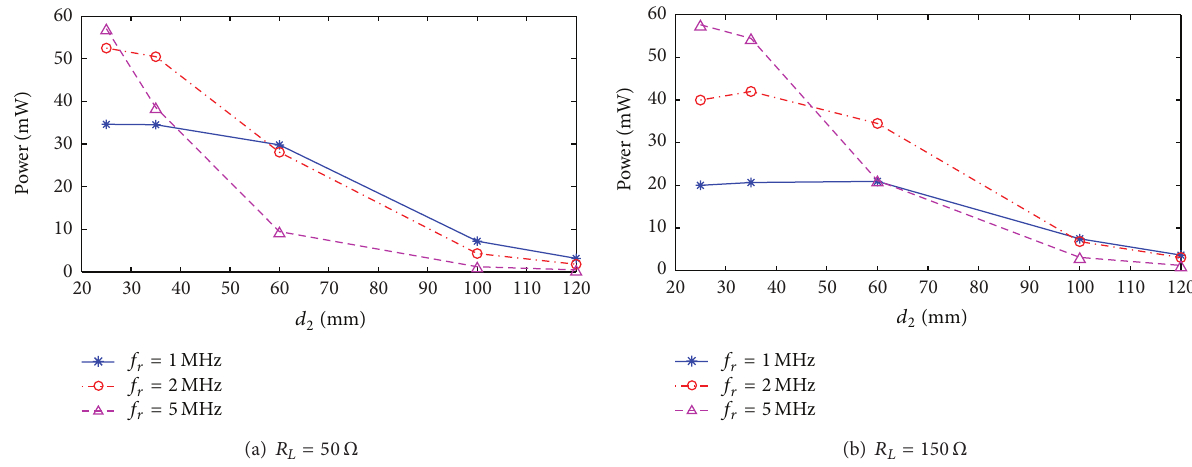
Figure 7: Variations in power transmission characteristics with various resonance